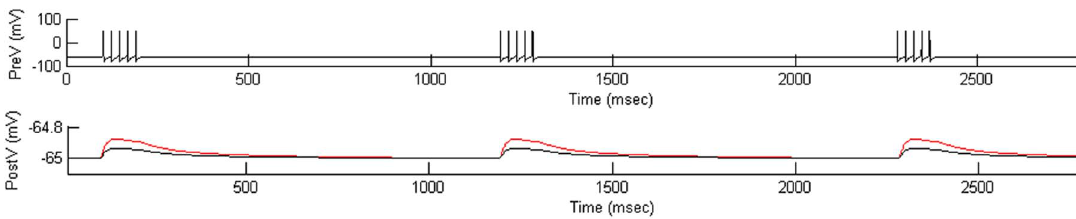
Figure 4. The effect of low intracellular Mg 2 + on NMDAR model. PreV: the voltage of the presynaptic neuron, induced to fire in three bursts of action potentials; PostV: the postsynaptic potential from NMDA synaptic current in response to input from presynaptic cell above. Black trace was the response in normal intracellular Mg 2 + (1 mM) and the red trace was the response in low intracellular Mg 2 + (0.1 mM). The amplitude of postsynaptic potential increased as the intracellular Mg 2 + concentration dropped to one tenth the normal value by unblocking the NMDAR